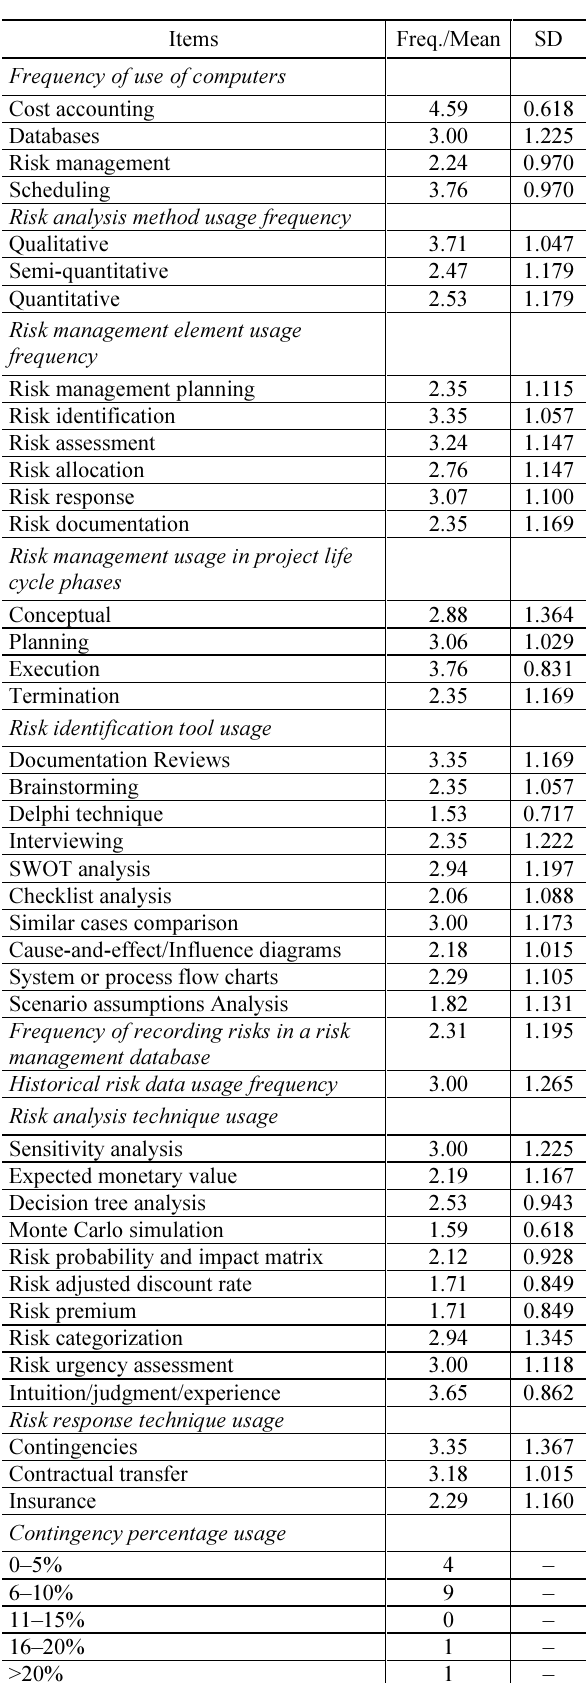
Fig. 1. Individual risk management knowledge and